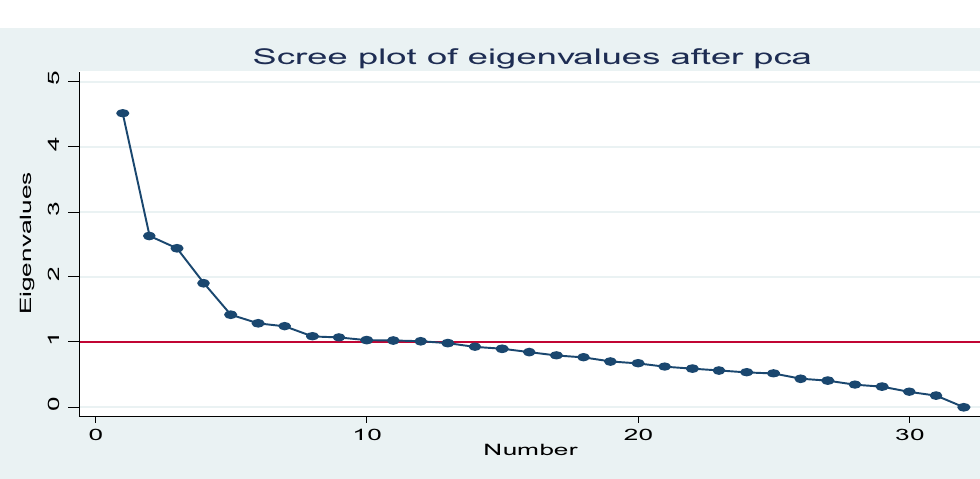
Figure 2. Scree plot showing retained variables after Principal component analysis